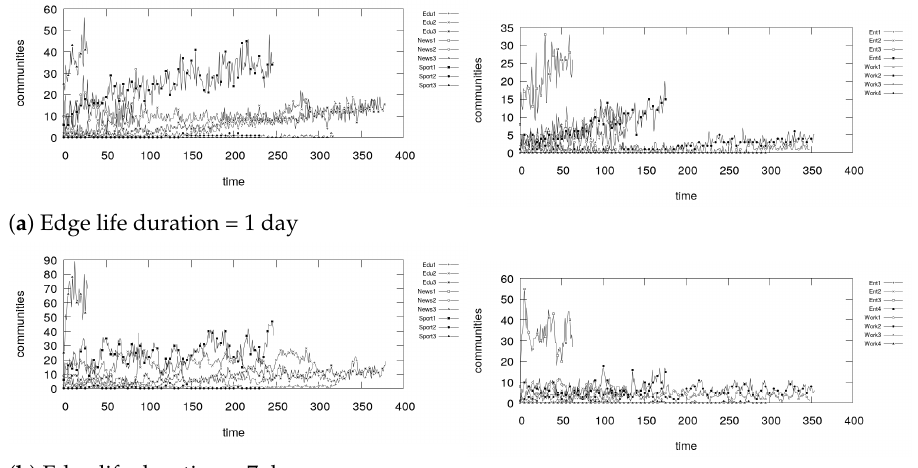
Figure 2. Number of communities detected by Democratic Estimator of the Modular Organization of a Network (DEMON).